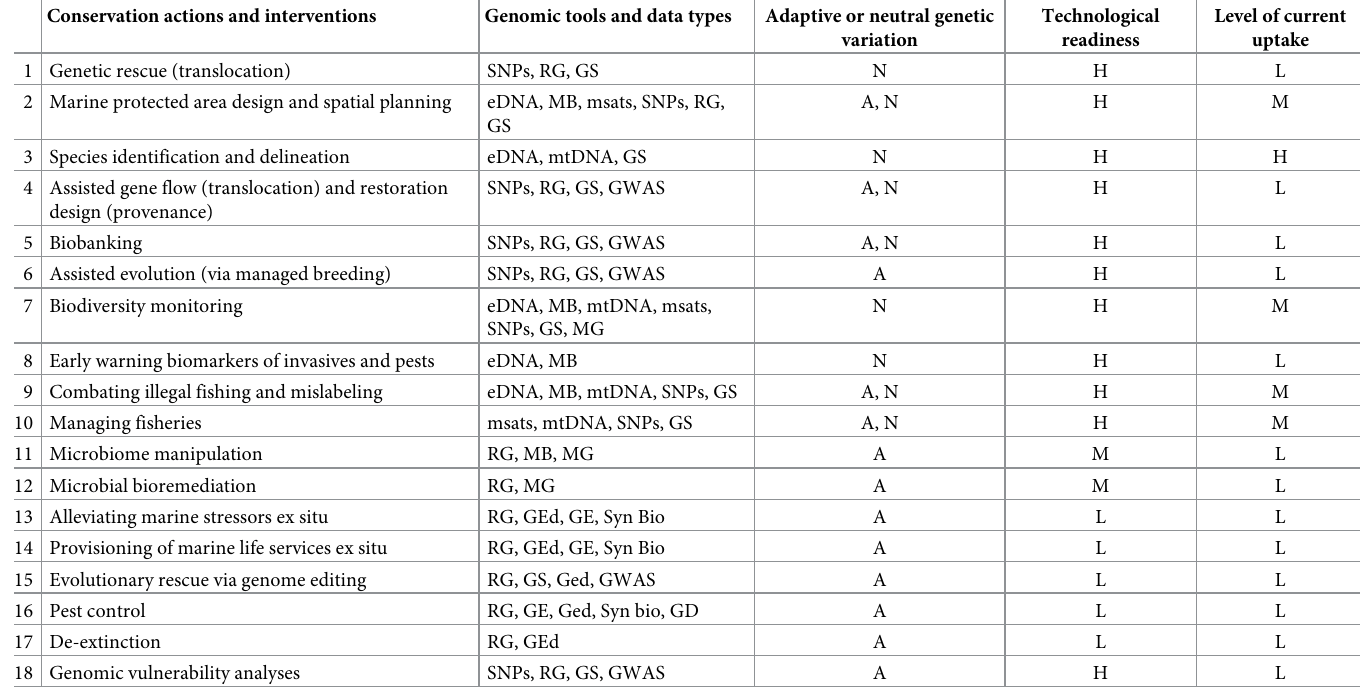
Table 1. Genomic/genetic marine conservation actions and interventions addressed in this